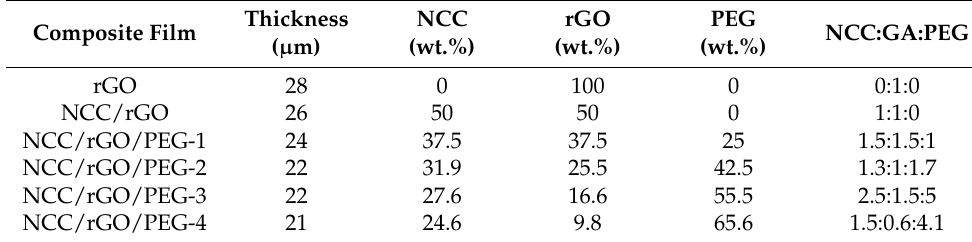
Figure 1. The main preparation process of the samples. Table 1. Content of each component in composite films and the thickness of the composite film.